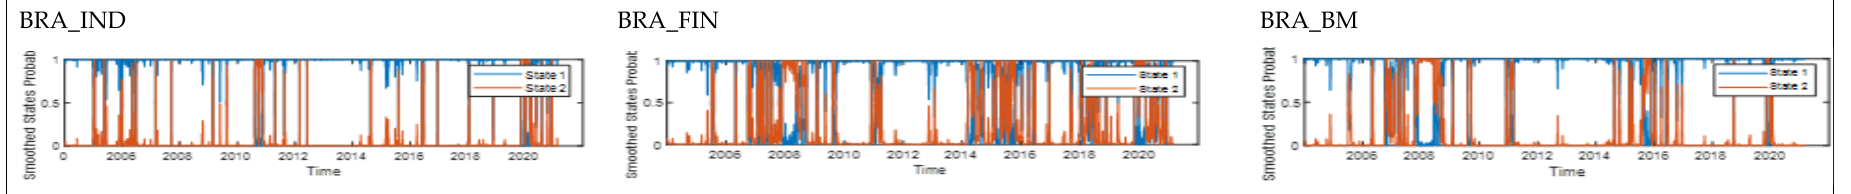
Figure A1. The plots of smoothed probabilities of industrials in panel ( A ), financials in panel ( B ), and basic materials in panel ( C ) based on state 1 and state 2 of the US, India, SA, Poland, and Brazil.